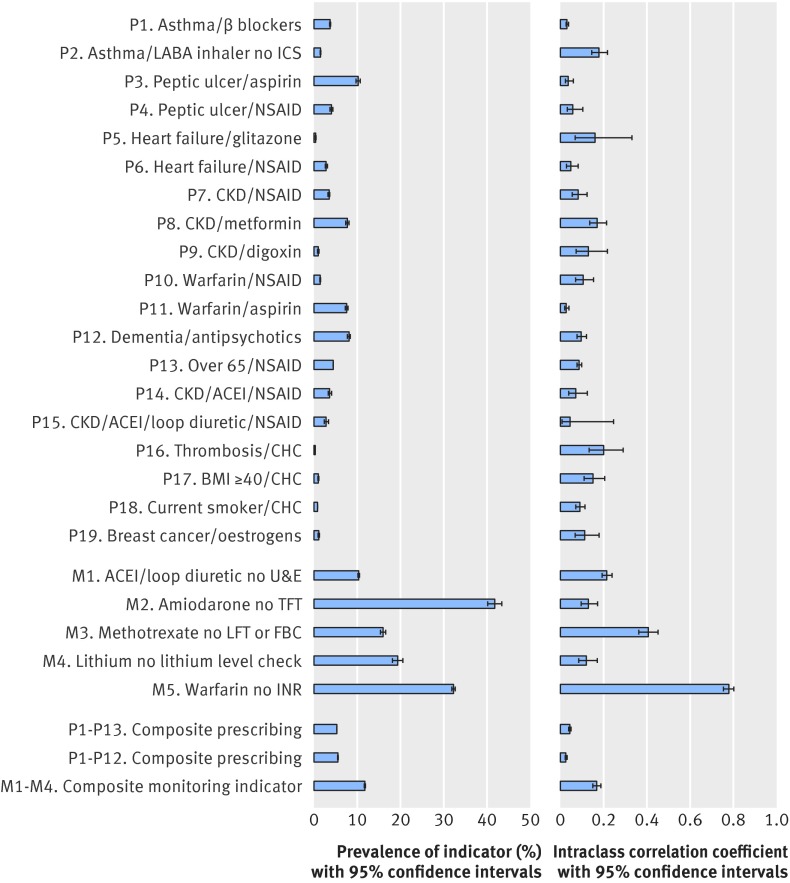
Fig 4 Prevalence and intraclass correlation coefficients for individual and composite indicators of potentially hazardous prescribing in general practice